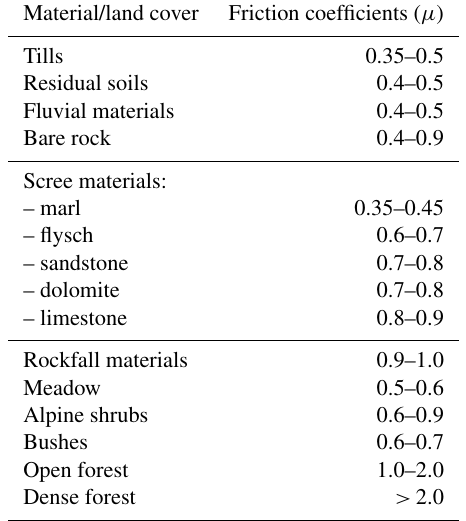
Table 2. Coefficients of friction for different materials and land cover (compiled from van Dijke and van Westen, 1990; Dorren and Seijmonsbergen, 2003; Wichmann,